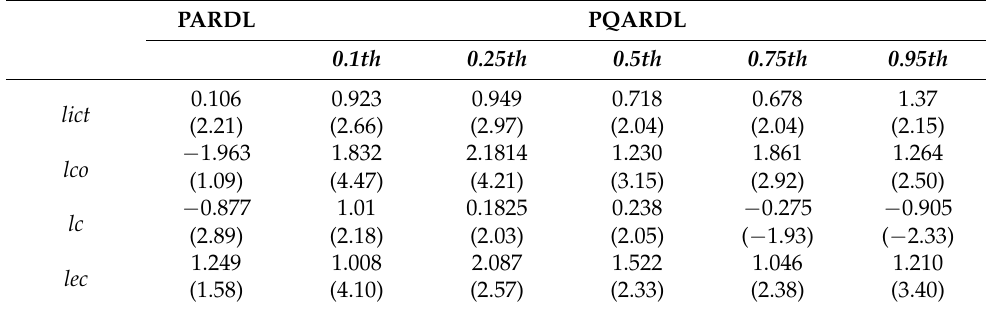
Table 7. Long-run Results.